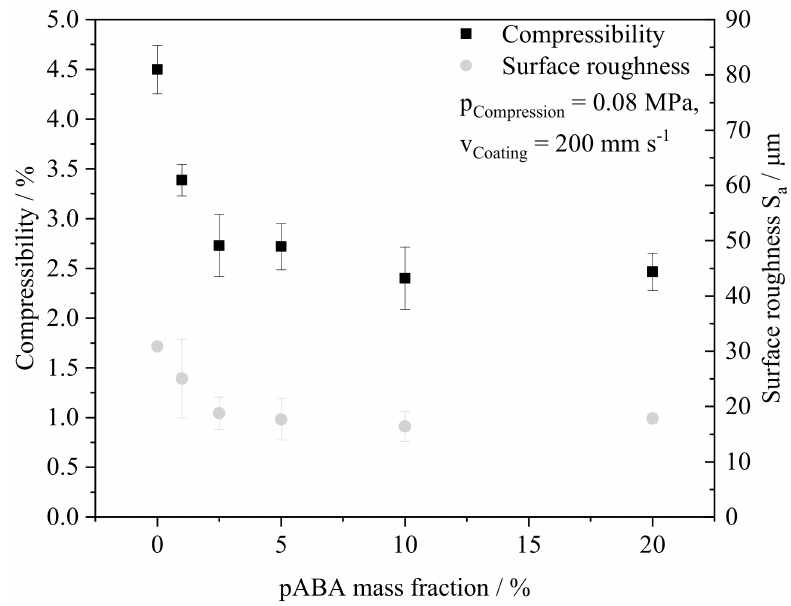
Figure 7. Overview of powder compressibility and powder surface roughness in dependence on contained fractions of pABA, n =